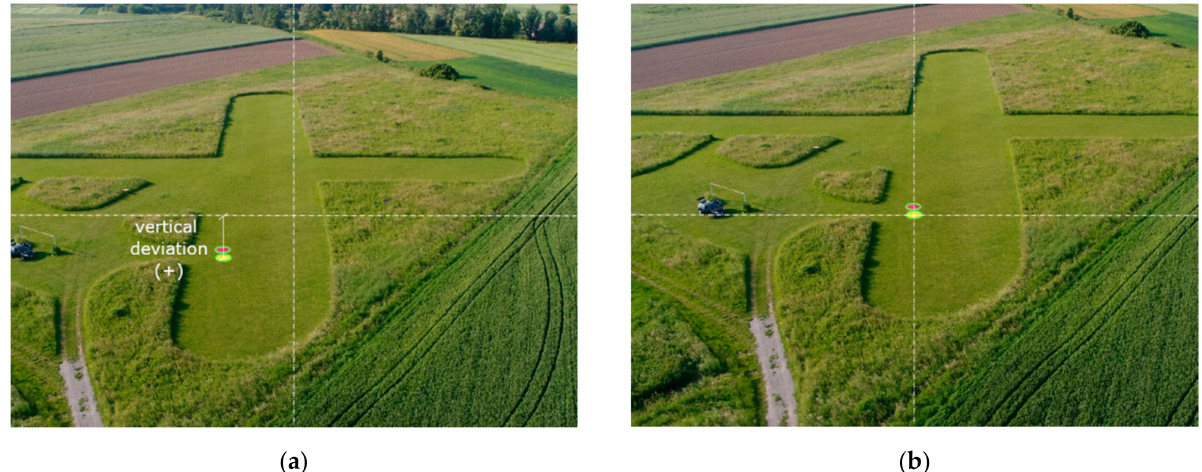
Figure 4. Samples of pictures gathered by the on-board camera with marked dedicated runway signs system; ( a ) incorrect configuration; ( b ) correct configuration-aircraft is aiming the signs system. Crossed dash-dot lines mark the center of the image and the real aiming